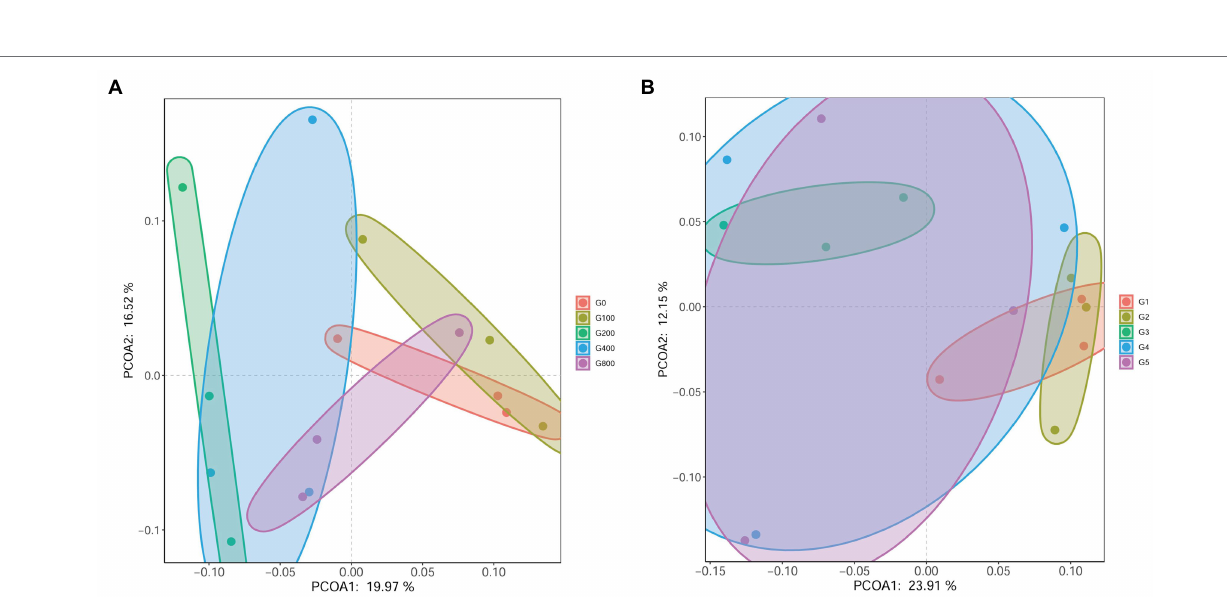
FIGURE 7 | Principle coordinate analysis (PCoA) based on weighted-unifrac (A) and unweighted-unifrac (B) analysis of bacterial profiles from intestines of O. mykiss ( n = 3).